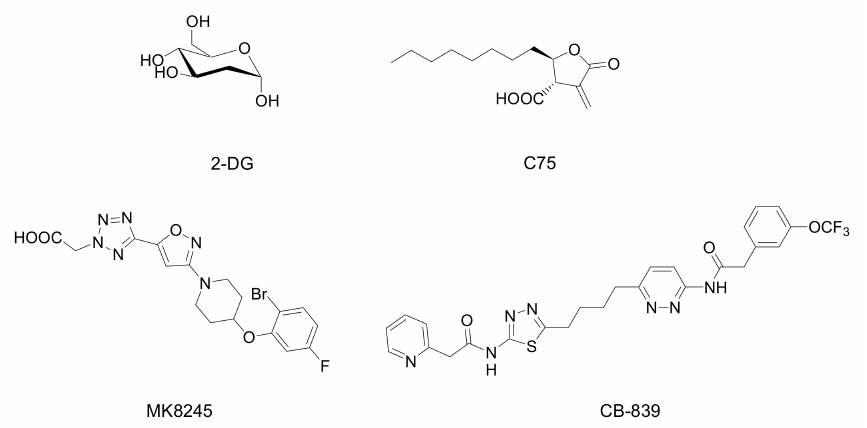
Figure 2. Chemical structures of selected metabolic drugs tested to contrast the virus replication: 2-deoxy-D-glucose (2-DG, phosphoglucose isomerase inhibitor), C75 (FAS inhibitor), MK8245 (SCD1 inhibitor), and CB-839 (glutaminase